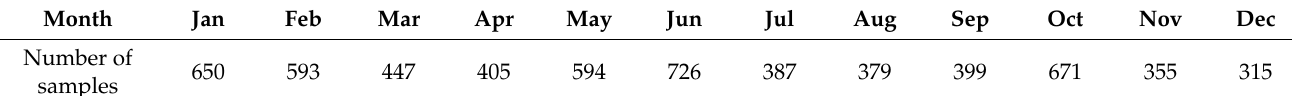
Table 1. The number of samples collected monthly from January to December 2018.